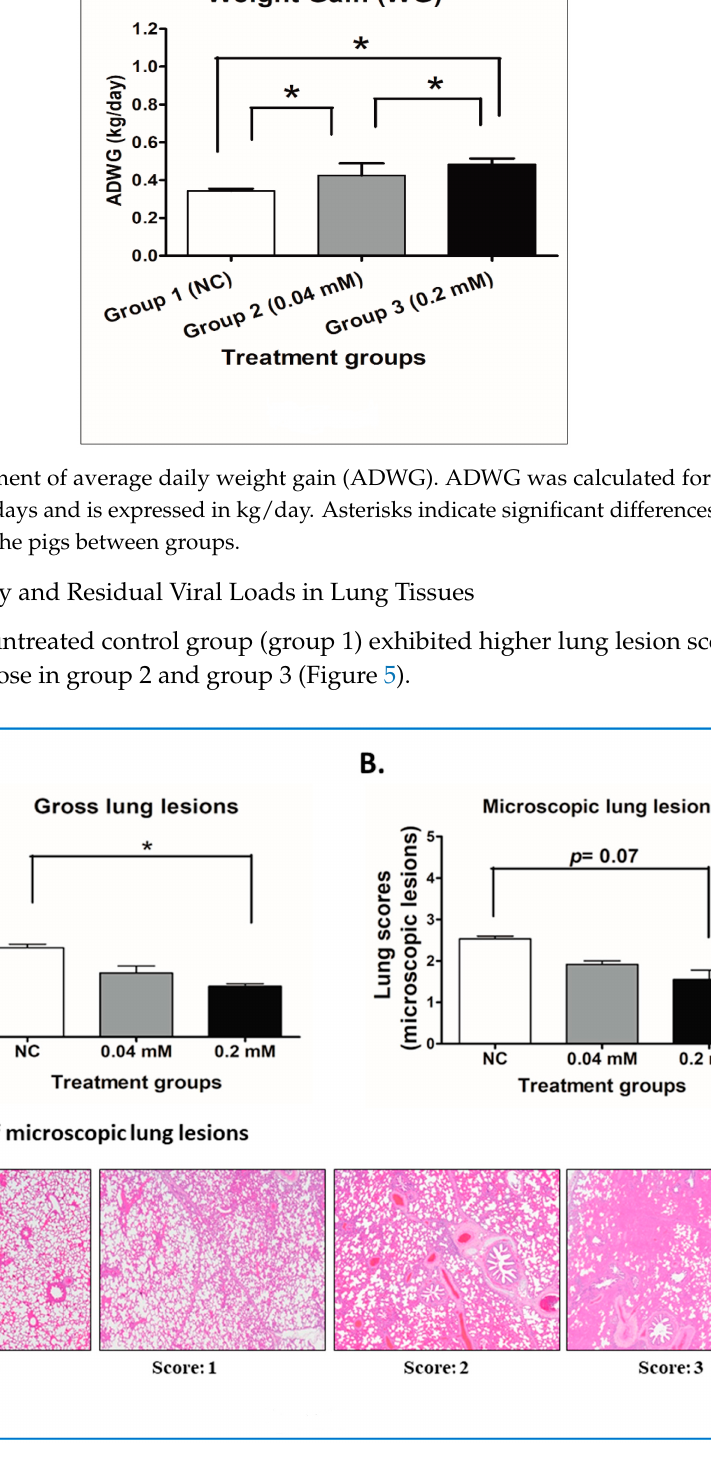
Figure 5. Lung pathology. Scoring of lung lesions was performed for all pigs in each group. Lung scores were plotted as the mean values of lesions scored in the five lobes of the lung. ( A ) Gross lung lesion scores, ( B ) microscopic lung lesion scores, and ( C ) scoring of microscopic lesions were recorded according to a 4-point scale from 0 to 3, with 0 indicating no lesion, 1 indicating mild interstitial pneumonia, 2 indicating moderate/multifocal interstitial pneumonia, and 3 indicating severe intense/diffuse interstitial pneumonia. Asterisks indicate significant differences (* p < 0.05) in pig lung lesions between